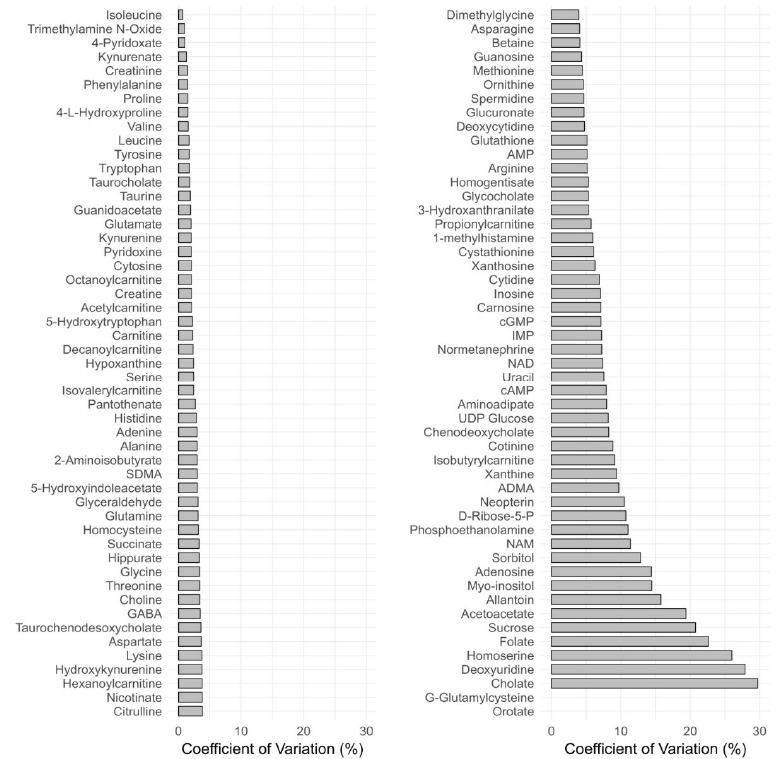
Figure 2. Interbatch variation of high concentrations of spiked quality control (QC) serum samples (N = 6) analyzed on 3 different days. Data not shown for g-glutamylcysteine and orotic acid (coefficient of variation (CV) > 30%).